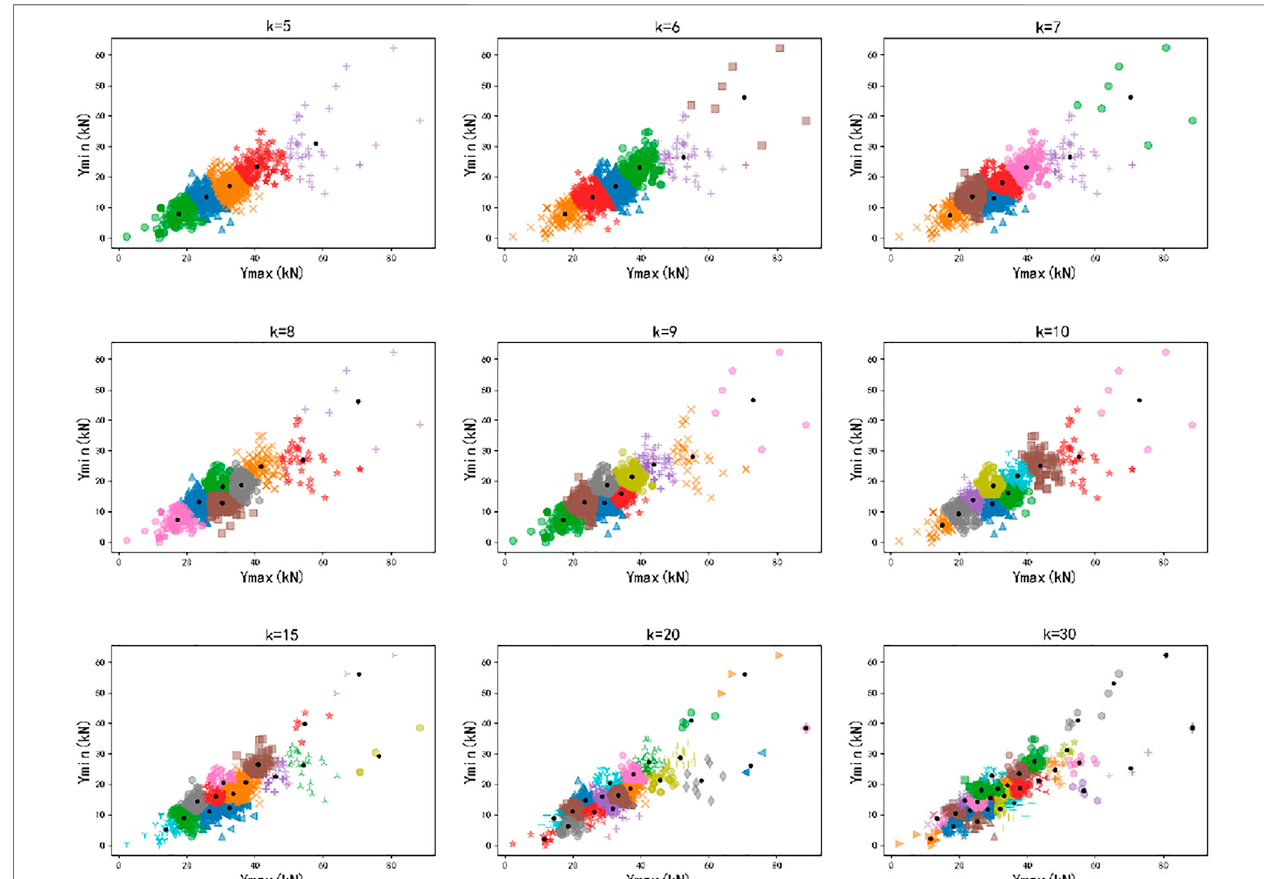
FIGURE 4 | Cluster distribution of different k